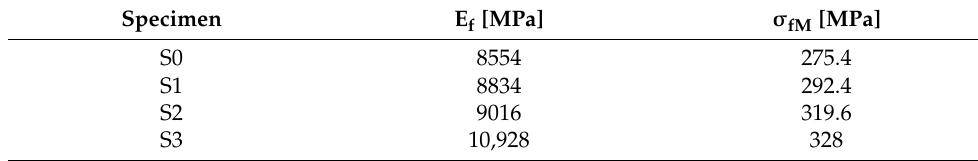
Figure 4. Flexural strength. Table 9. Results of flexural tests. Table 9. Results of flexural